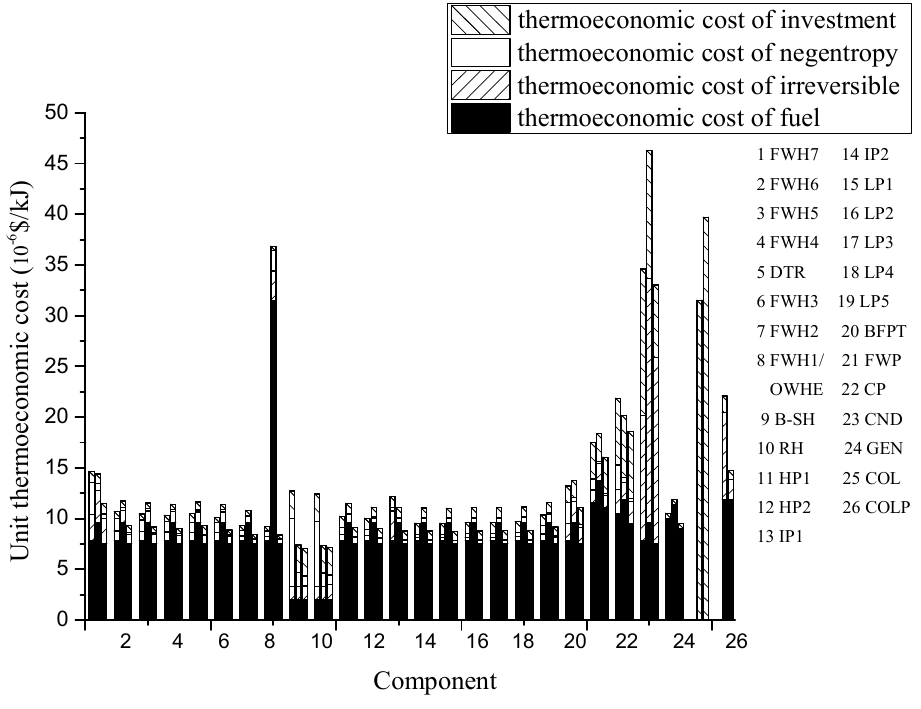
Figure 13. Composition structure of thermo-economic cost in (left to right for each component): coal-fired power-generation system with MEA-based CO 2 capture, solar-aided coal-fired power generation with CO 2 capture, and solar-aided CO 2 capture coal-fired power generation. Note: BFPT = feed-water pump turbine; SH = boiler superheater; CND = condenser; COL = collector; COLP = collector oil-pump; CP = condenser water pump; DTR = deaerator; FWH = feed-water heater; FWP = feed-water pump; GEN = generator; HP = high-pressure turbine; IP = intermediate-pressure turbine; LP = low-pressure turbine; OWHE = oil–water heat exchanger; RH = reheater.